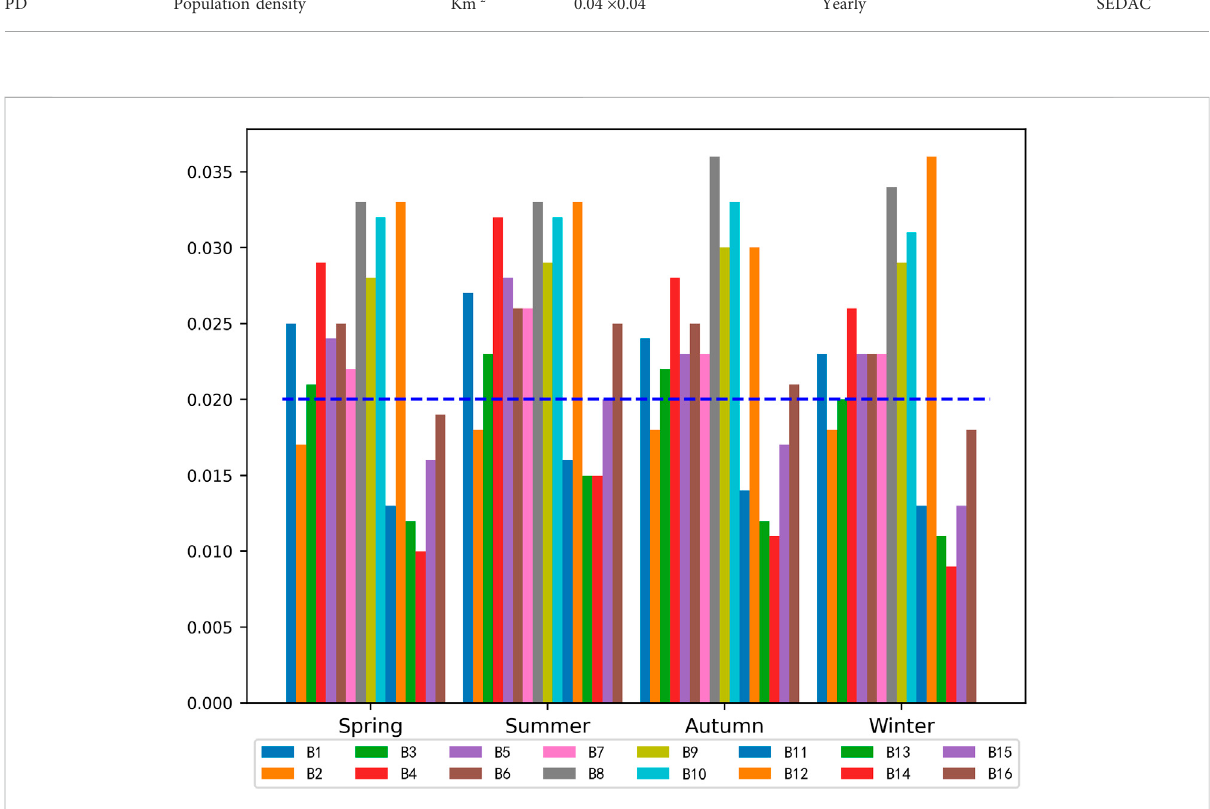
FIGURE 2 Feature importance for Himawari-8 satellite bands in the models of four seasons, where the blue dashed line represents the x=0.02 line.